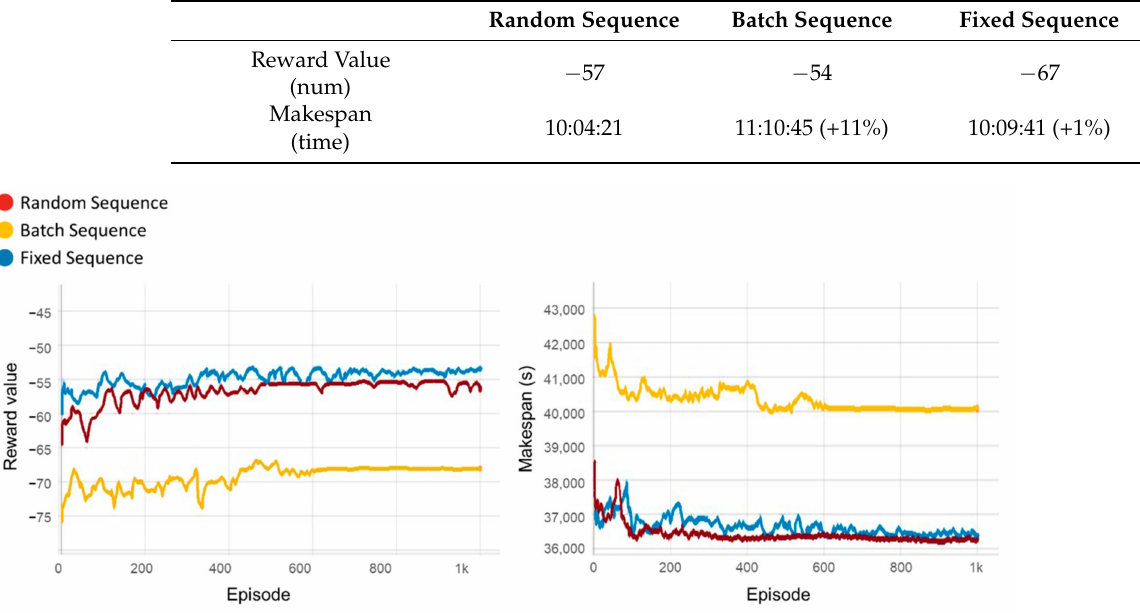
Table 5. Reward value and makespan comparison in Case B.